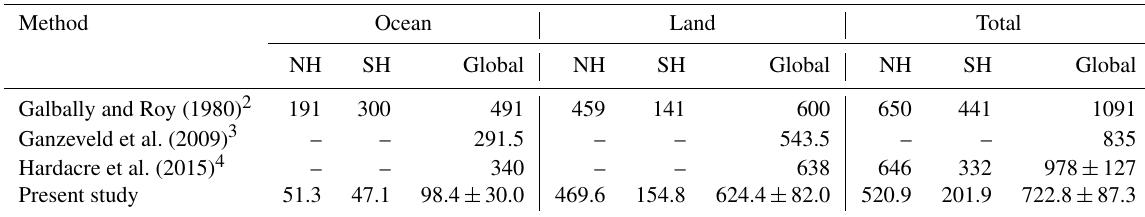
Table 2. Mean ozone dry deposition based on the MACC data for the years 2003–2012 (Tg O 3 yr − 1 ) 1 , and from other studies that also report the oceanic component. The uncertainties are ± 1 σ .